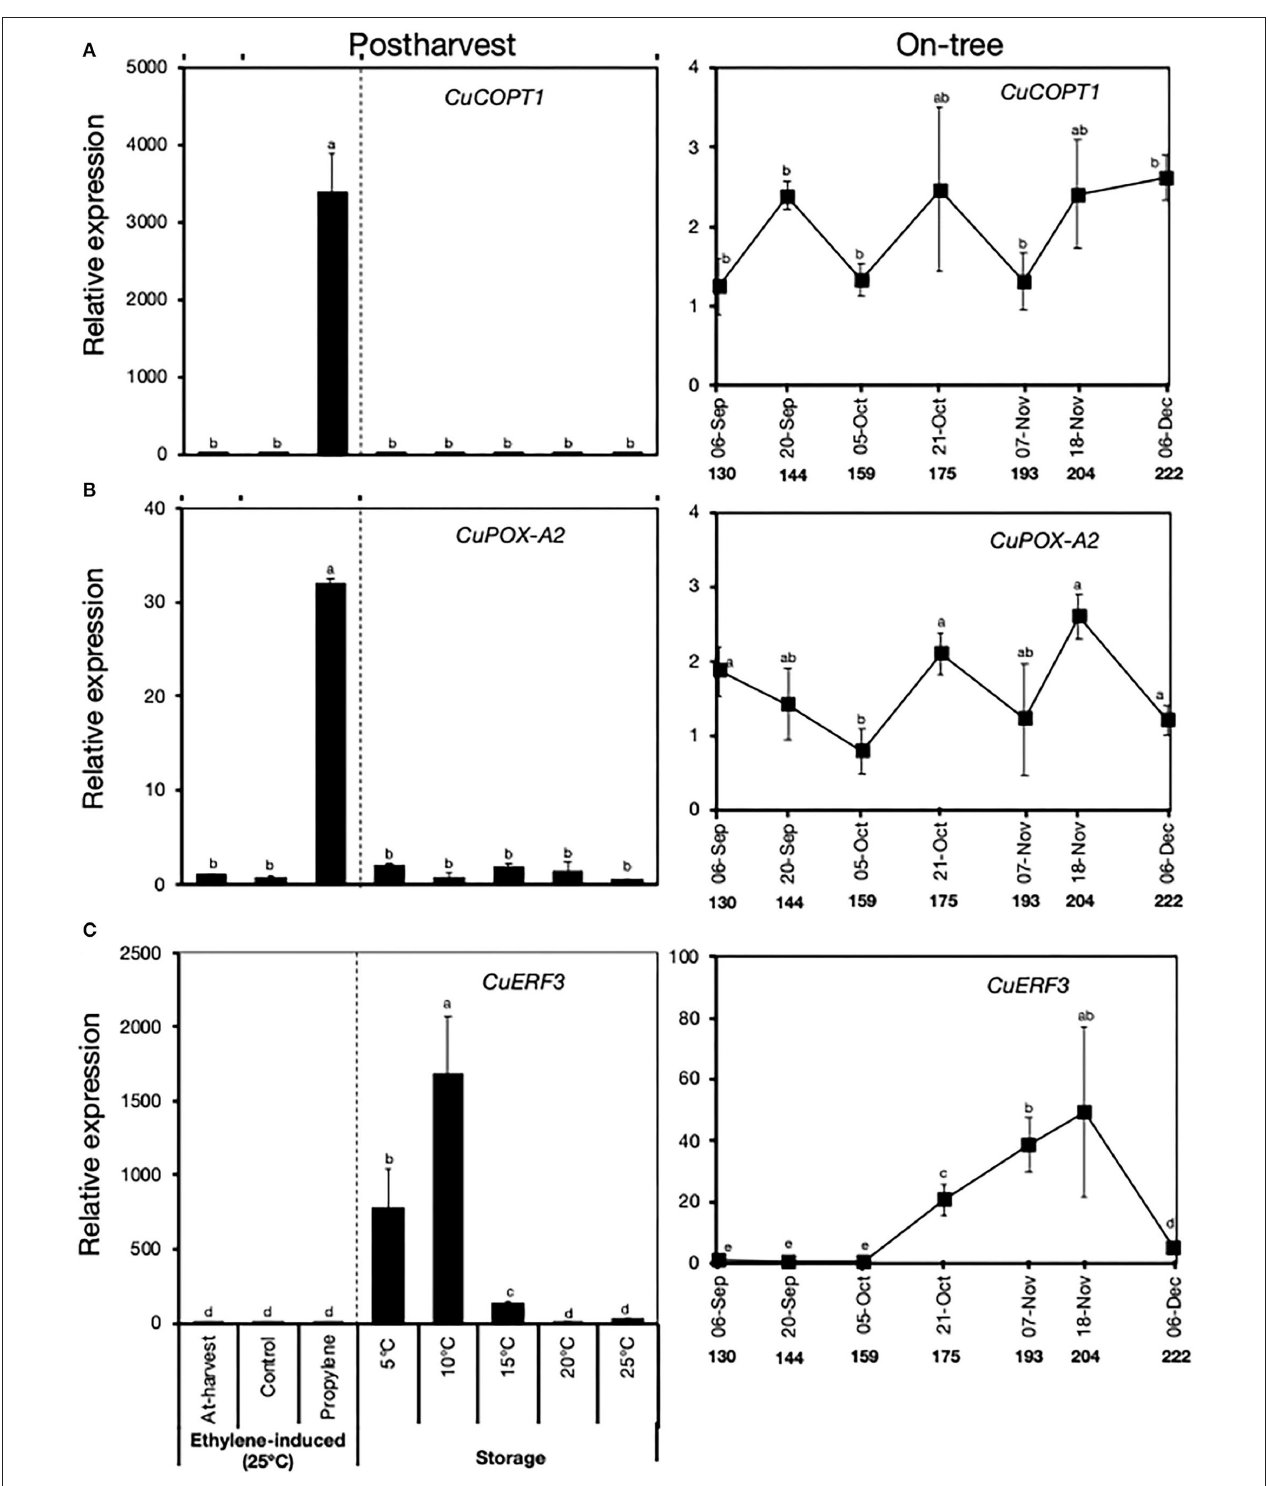
FIGURE 7 | Relative expression levels of ethylene-specific (A,B) and low temperature-specific (C) genes during postharvest and on-tree peel degreening in Satsuma mandarin fruit. Values below the horizontal axis of on-tree graphs indicate the days after full bloom. CuCOPT1 ( Ciclev10030036m.g ), CuPOX-A2 ( Ciclev10015790m .g), and CuERF3 ( Ciclev10009593m .g). Data points represent the mean ( ± SE) of three fruit and different letters indicate significant differences in ANOVA (Tukey’s test, P < 0.05).